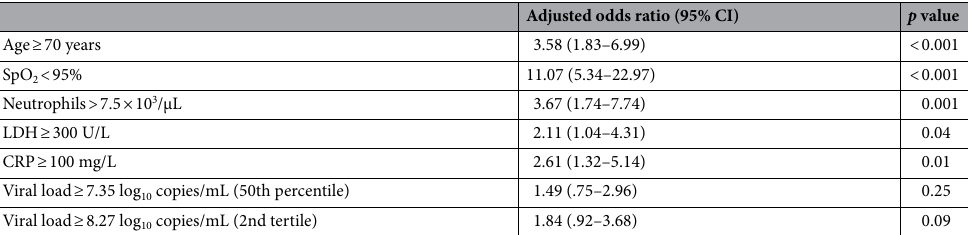
Table 5. Independent predictors of unfavorable outcome (ICU admission and/or death): Multivariable logistic regression model. The final multivariable model was composed of five variables (therefore 17 events per variable) demonstrated as independent predictors of unfavorable outcome: Age ≥ 70 years, SpO 2 < 95%, neutrophils > 7.5 × 10 3 /µL, LDH ≥ 300 U/L, and CRP ≥ 100 mg/L). Such model reported a Beta Coefficient of -4.08 (standard error = 0.46), a Wald statistic of 78.72 (degrees of freedom = 1), and an overall apparent performance of 84.2% (sensitivity = 70.6%, specificity = 89.4%, PPV = 70.3%, NPV = 89.1%). The variables included were explanatory and contributed to giving the model an ability to explain roughly 52.1% of the variation of the outcome (Nagelkerke R 2 value = 0.521). A higher nasopharyngeal viral load (above the second quartile or the second tertile) was not independently linked to an increased risk of ICU admission or death.